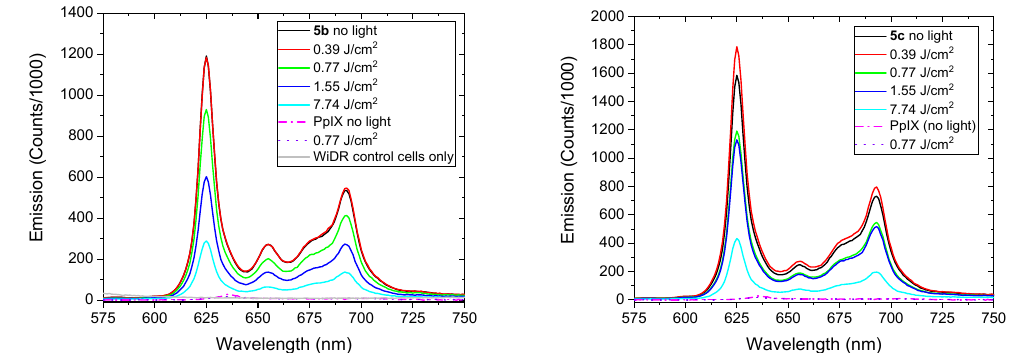
Figure 7. Representative fluorescence spectra of compounds 5b ( Left ) and 5c ( Right ) blue light doses. Spectra are averages of 3–5 experiments except for control experiments with PpIX and cells only.